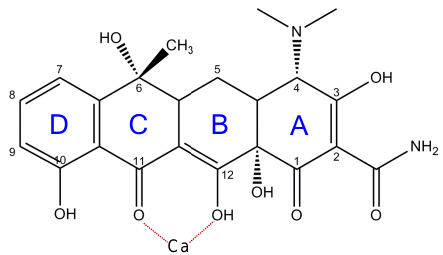
Figure 4. Chemical structure of TC and possible complexation sites with Ca(II).